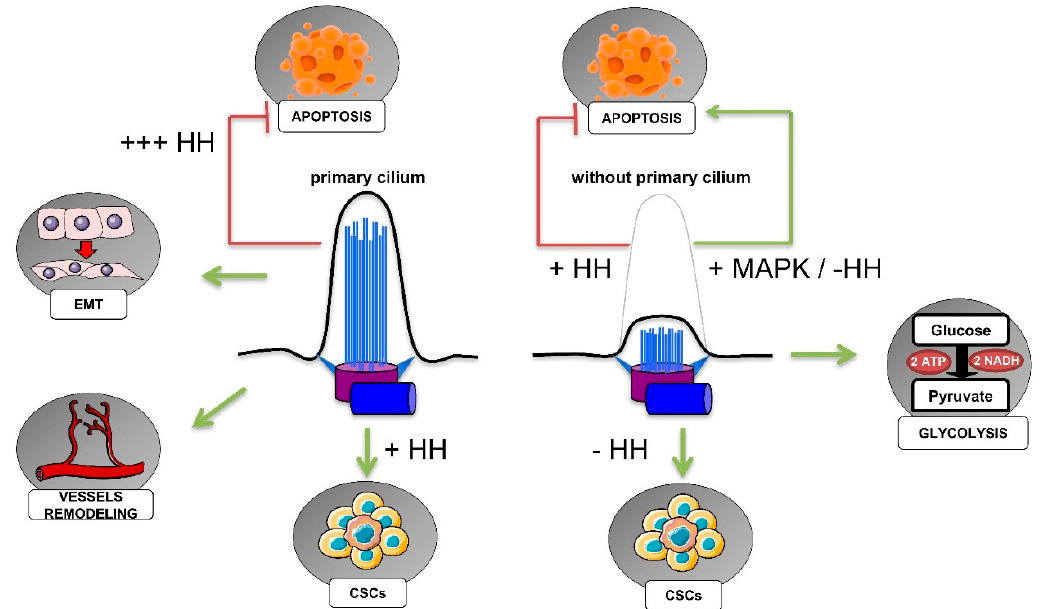
Figure 5 . Implication of the primary cilium in cancer hallmarks. In cancer, the presence or absence of the primary cilium can influence cell metabolism, cell invasion, and resistance to cell death, as discussed in the text. Despite the role of the endothelial primary cilia in vessel remodeling, the role of the primary cilium in tumor angiogenesis is not yet known. ATP: Adenosine triphosphate; CSCs: Cancer stem cells; EMT: Epithelial-to-mesenchymal transition; HH: Hedgehog pathway; MAPK: mitogen-activated protein kinase pathway; NADH: Reduced nicotinamide adenine dinucleotide.